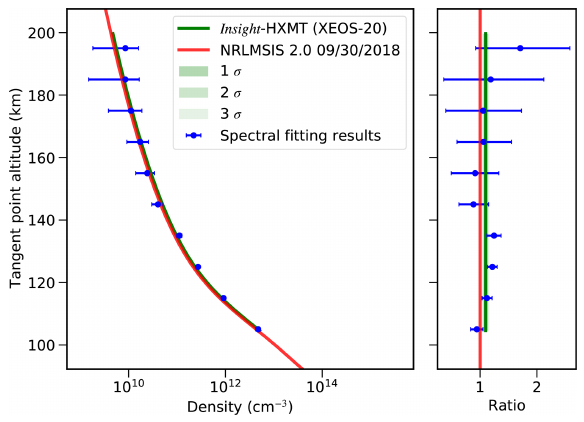
Figure 15. Comparison of retrieved results based on energy spec- trum fitting and light curve fitting. The solid blue line represents the retrieved results of spectrum fitting, the solid red line represents the model density profile of NRLMSIS 2.0, and the solid green line represents the retrieved results of the light curve in the energy range of 1.0–2.5keV. Right panel: all density profiles are normalized to the NRLMSISE 2.0 density profile on 30 September